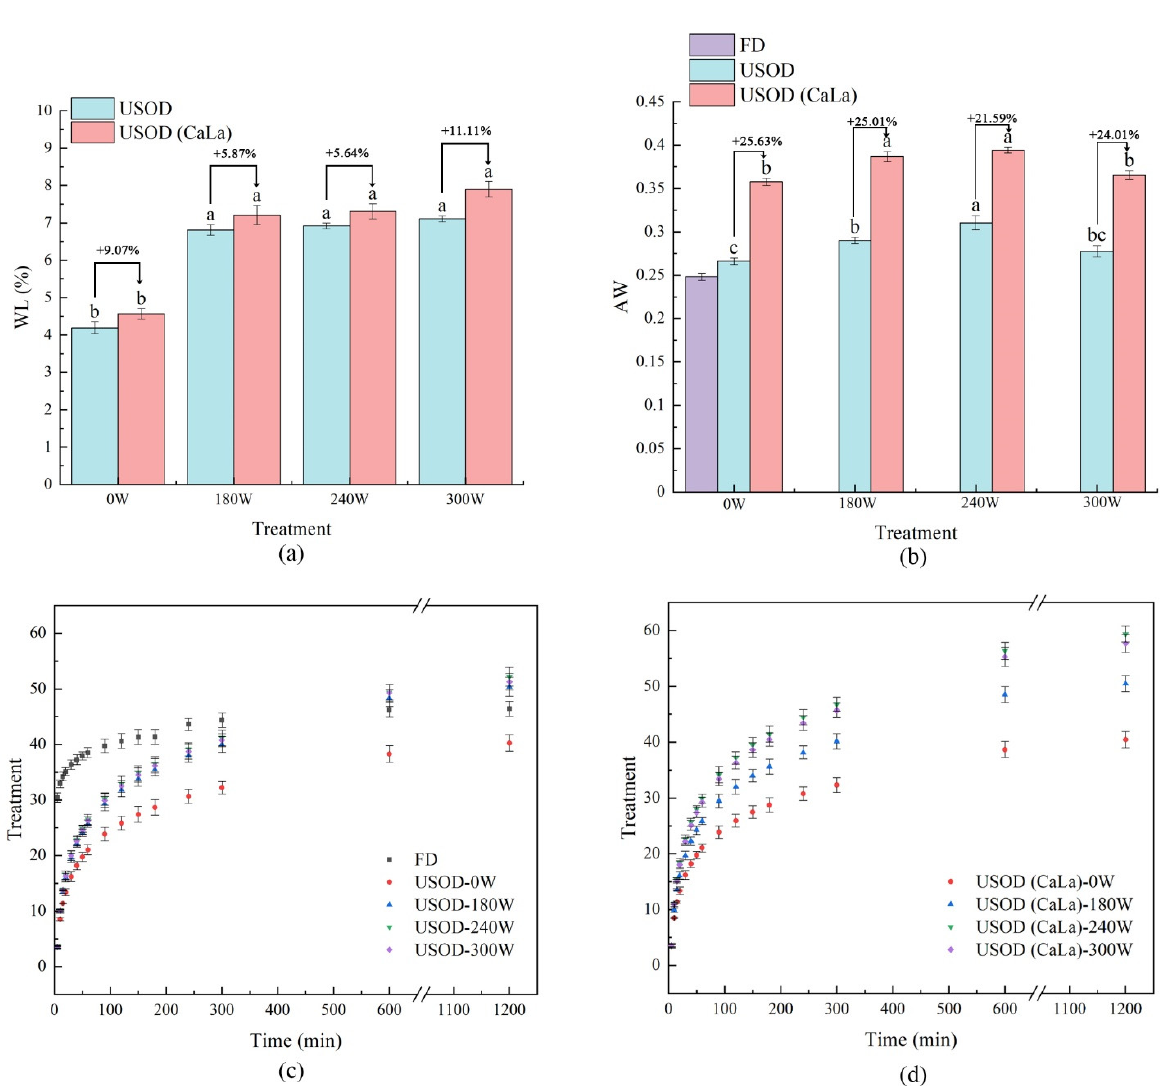
Figure 1. WL ( a ), Aw ( b ) and RC ( c , d ) of freeze-dried yellow peach slices with different treatments. The means between different ultrasonic power levels on the same conditions indicated by lowercase letters differ significantly.